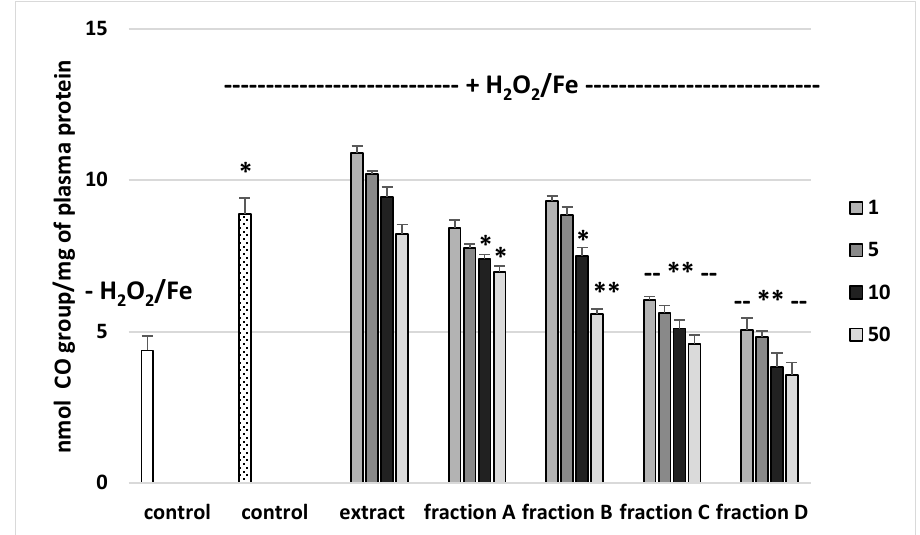
Figure 3. E ff ects of the extract and the four fractions (A–D, concentration range 1–50 µ g / mL, pre-incubation time—5 min) from Paulownia Clone in Vitro 112 leaves on the oxidative damages of plasma protein treated with H 2 O 2 / Fe (incubation time—25 min)-protein carbonylation. Results are given as mean ± SEM ( n = 6). Control negative (white bar) refers to plasma not treated with H 2 O 2 / Fe, whereas control positive (dot bar) to plasma treated with H 2 O 2 / Fe. One-way ANOVA followed by a multicomparison Duncan’s test: – p > 0.05, * p ≤ 0.05, ** p ≤ 0.02, compared with positive control (treated with H 2 O 2 / Fe); * p ≤ 0.05, compared between negative control and positive control.